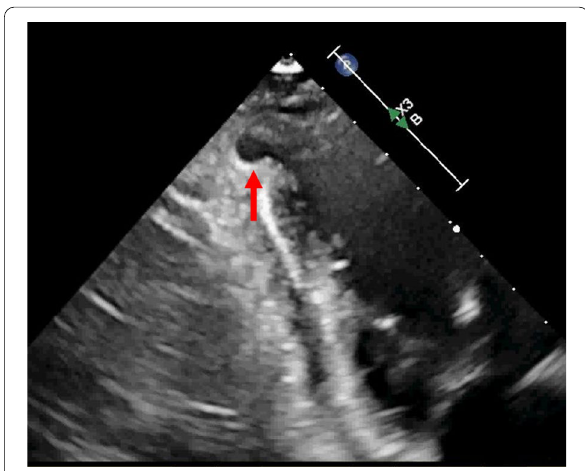
Fig. 1 Echocardiography (preoperative) aneurysm of the apex of the heart (arrow)